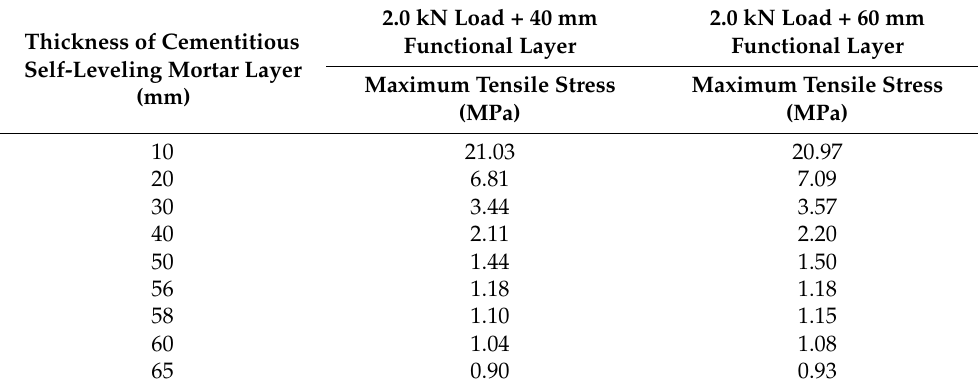
Table 4. Corresponding table of thickness and maximum tensile stress of cementitious self-leveling mortar